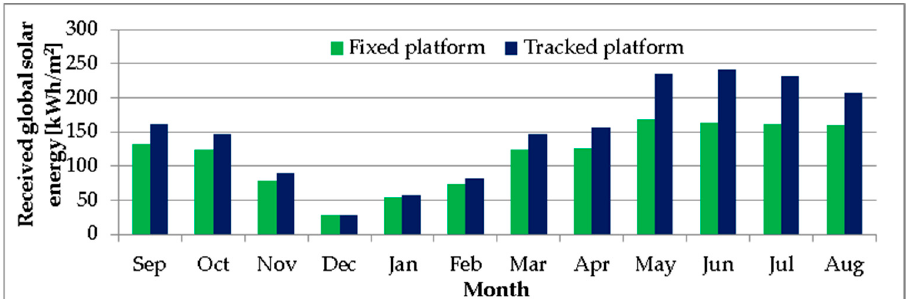
Figure 8. Monthly global solar energy received in the plane of the fixed ( E Gnf ) and on the tracked ( E Gnt ) PV platforms between September 2021 – August 2022.